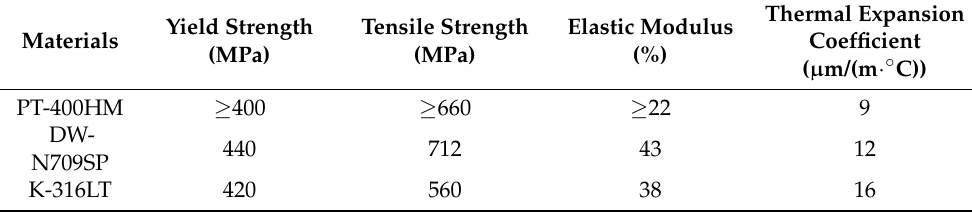
Table 5. Mechanical properties of the welding